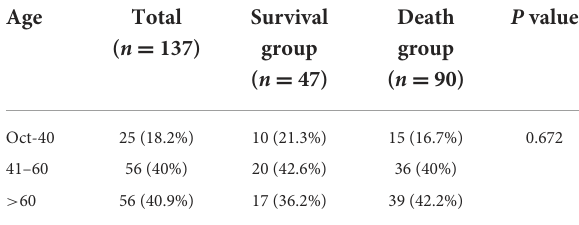
TABLE 1 Percentage distribution of age by outcome of septic